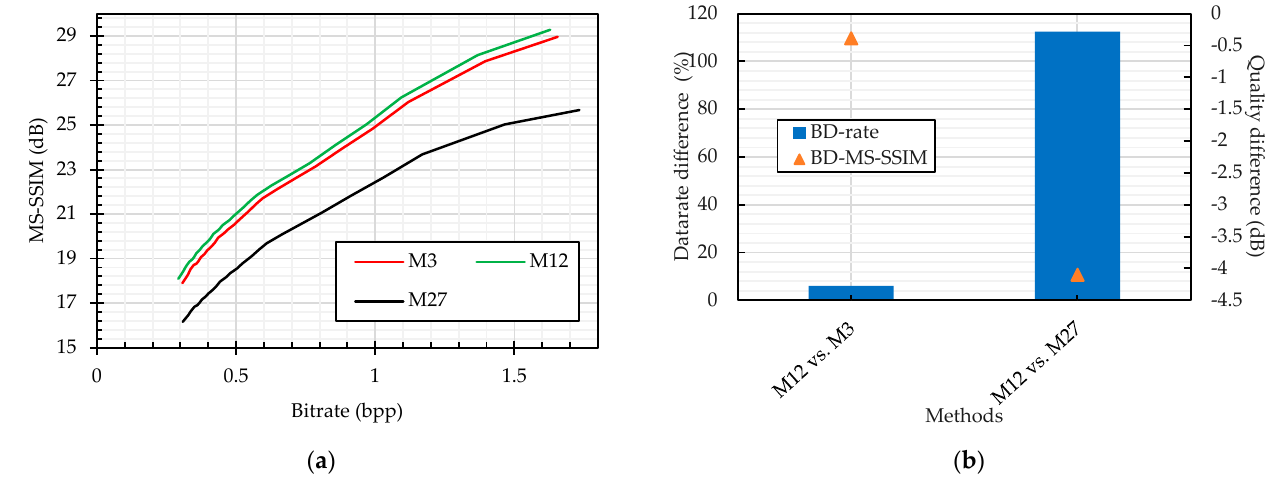
Figure 15. The JPEG compression analysis of plain and CPE images with chroma subsampling. ( a ) The RD curves and ( b ) the BD-measures plots.